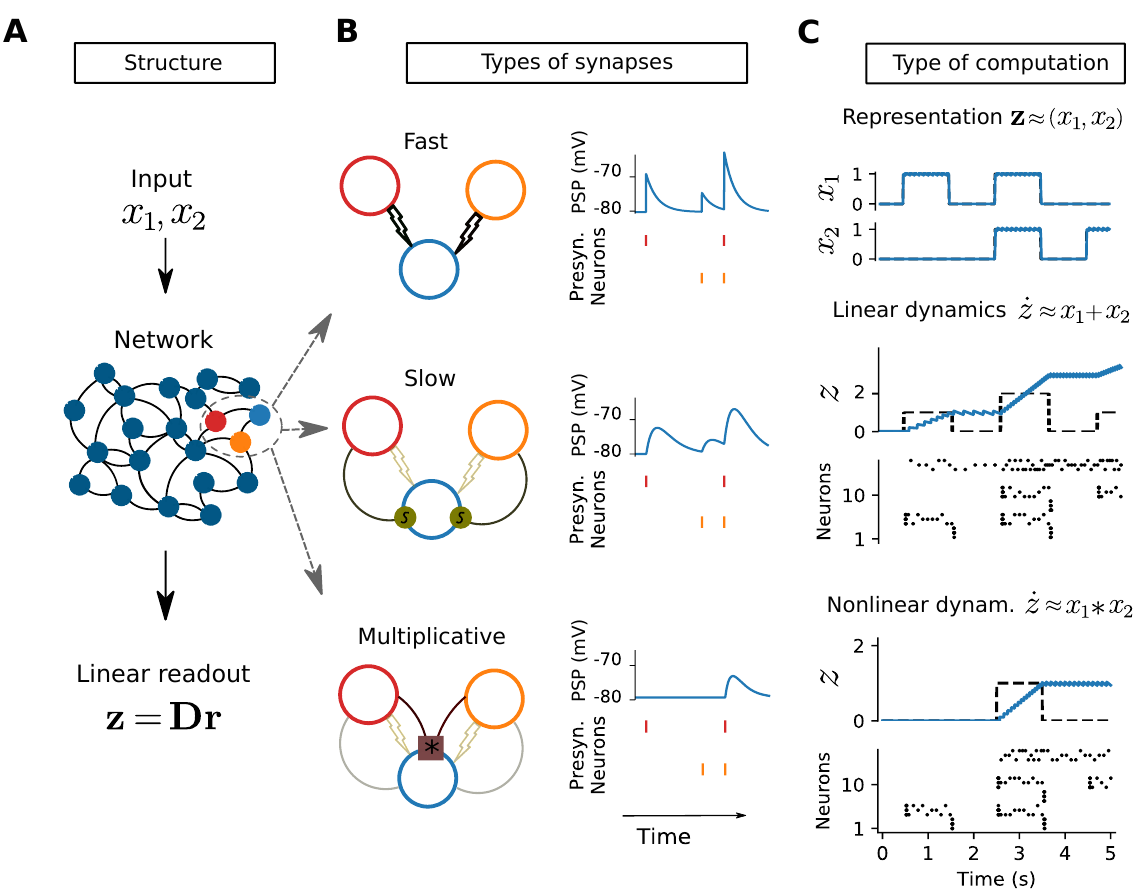
Figure 1 – Multiplicative Spike Coding Networks (mSCNs) can implement polynomial dynamics. (A) Schematic representation of the network. (B) The network has three types of synapses, illustrated for two neurons (red and orange) connecting to another (blue). The postsynaptic potential (PSP) of a cell endowed with multiplicative synapses will be affected only if the two presynaptic neurons fire very close in time to each other. Higher order multiplicative interactions can also be necessary, and are illustrated in Supp. Fig. S1. (C) Example computations enabled by the different types of synapses: (top) the network represents the two inputs ( x 1 and x 2 ). The blue line represents the output of the network, the dashed black lines the real input. (Middle) A network which computes the dynamical system ˙ z = x 1 + x 2 . The black dashed line represents the real sum of the inputs, the blue line represents the output of the network. (Bottom) A network which computes the x x x nonlinear dynamical system ˙ z = x 1 2 , and thus integrates the product of 1 and 2 . ∗ For both linear and nonlinear dynamics the fast synapses are also